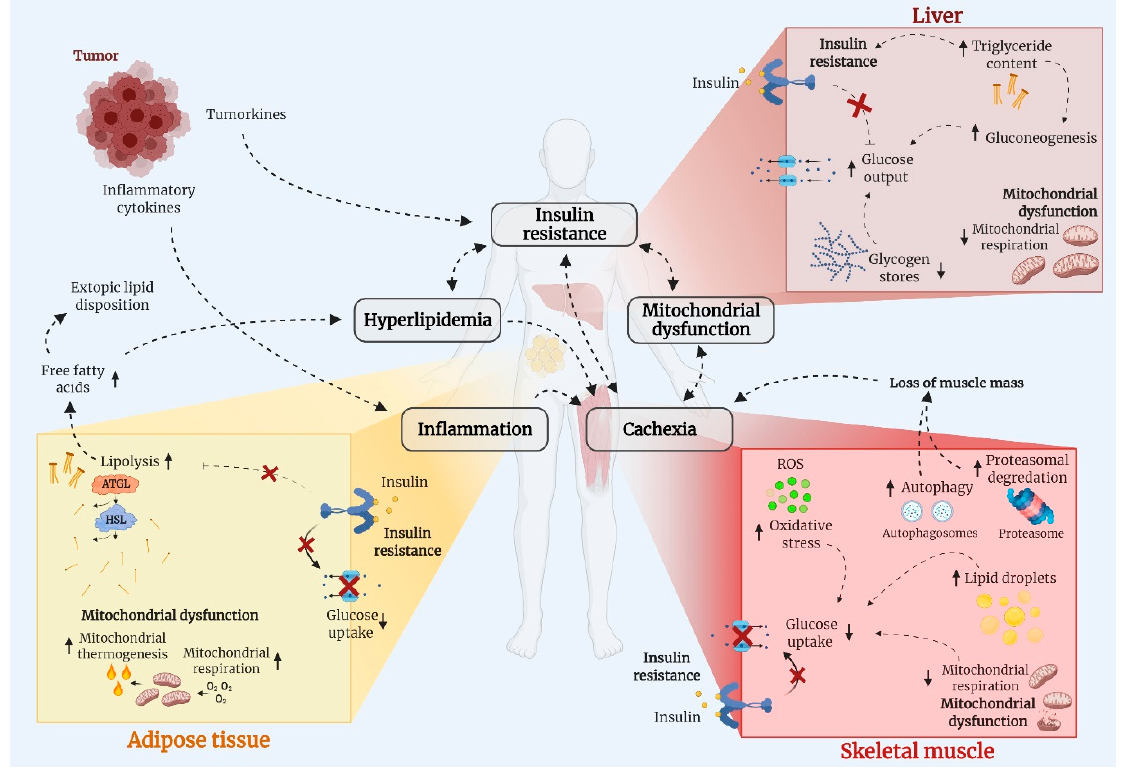
Figure 2. Cancer is associated with adverse changes of metabolic important tissues, including skeletal muscle (myocytes), adipose tissue (adipocytes), and the liver (hepatocytes). Those changes include insulin resistance, hyperlipidemia, mitochondria dysfunction, inflammation, and muscle mass loss (cancer cachexia) and there is significant tissue crosstalk. Abbreviations: ATGL; adipose triglyceride lipase, HSL; hormone sensitive lipase, ROS; reactive oxygen species.